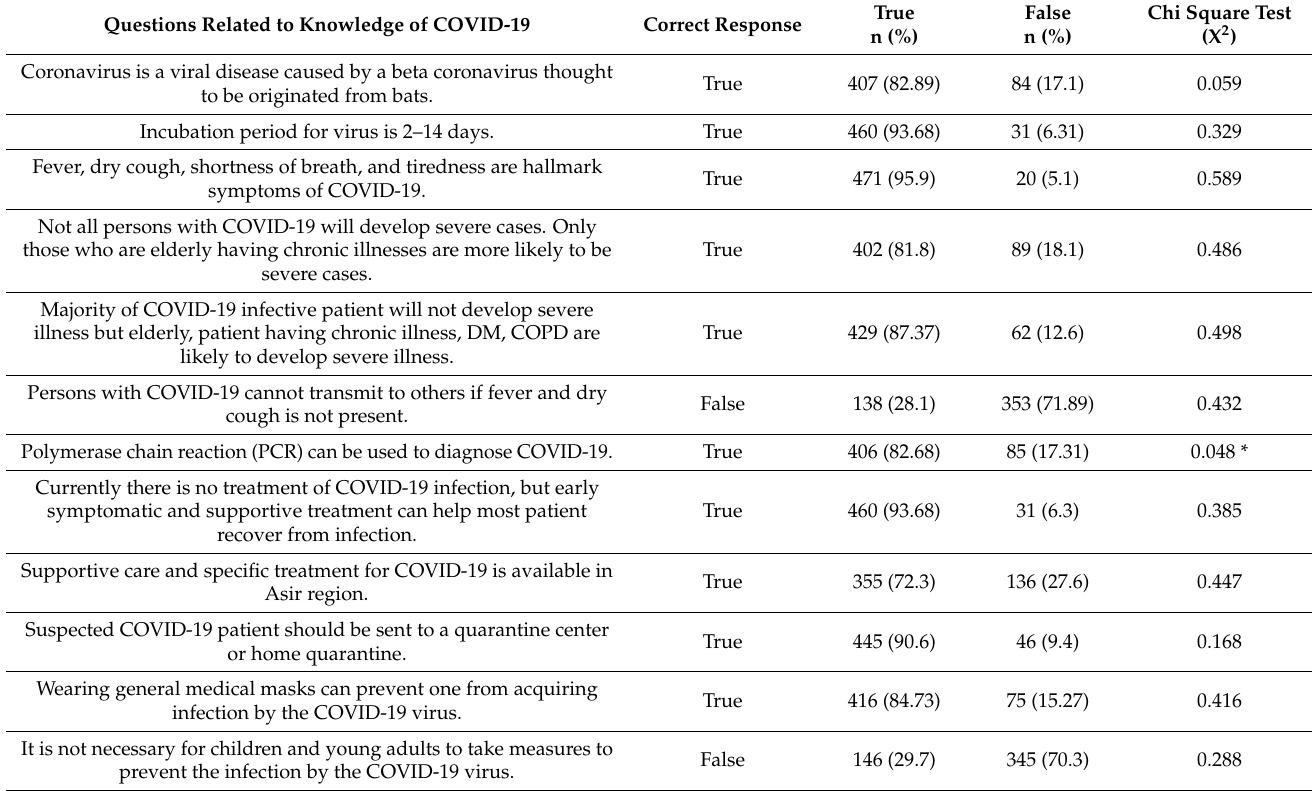
Table 2. Knowledge of HCPs about